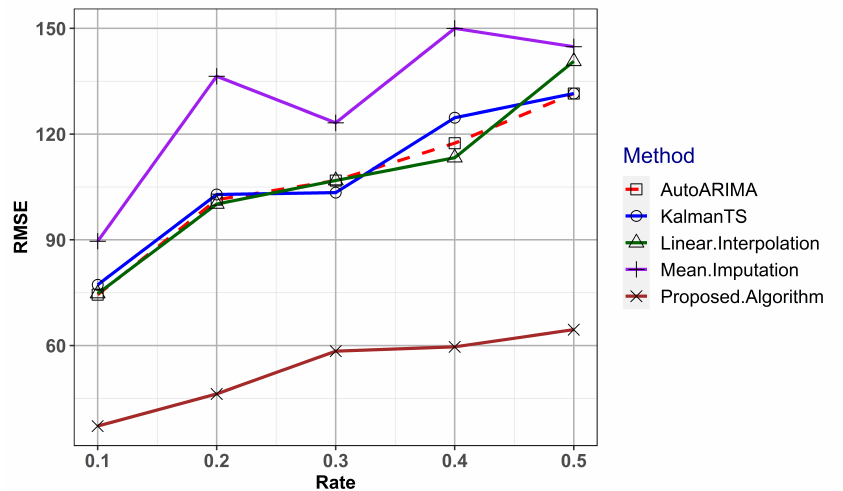
Figure 5. Performance Comparison of the Proposed method against Kalman smoothing on ARIMA models, Kalman smoothing on structural time series models, Linear interpolation, and Mean